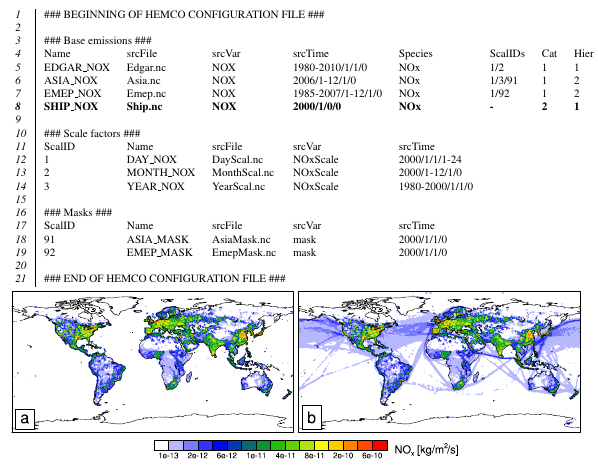
20 Figure 2. Sample HEMCO configuration file and resulting emis- sion fields calculated by HEMCO. Emission inventories (base emis- sions) are listed in lines 5–8 with the identification name (“Name”), (netCDF) filename (“srcFile”), file variable of interest (“srcVar”), and temporal resolution (“srcTime”: year/month/day/hour). The atmospheric model species name is given in the 5th column (“Species”), and all scale factors to be linked to the base emissions are listed in the 6th column (“ScalIDs”), separated by a forward slash. The emission category and hierarchy are defined in columns “Cat” and “Hier”, respectively. Scale factors and region masks are listed in lines 12–19, starting with the scale factor ID (“ScalID”, corresponding to the IDs given in the base emission section), the identification name (“Name”), and the data file information (“src- File”, “srcVar”, “srcTime”, as for base emissions). (a) and (b) show the emission maps calculated by HEMCO without and with the ship NO x inventory (in bold, line 8), respectively. See Sect. 2.3 for more